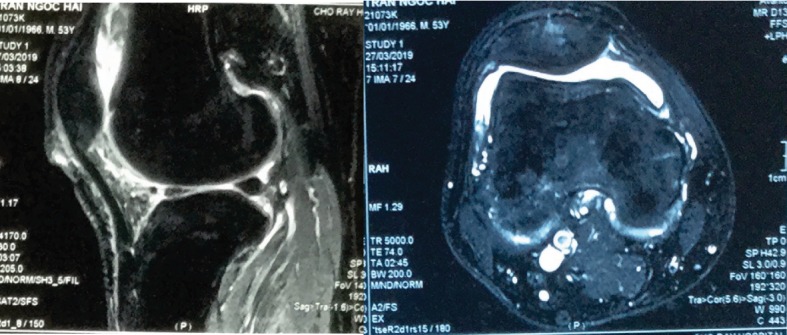
MRI after 3 months.